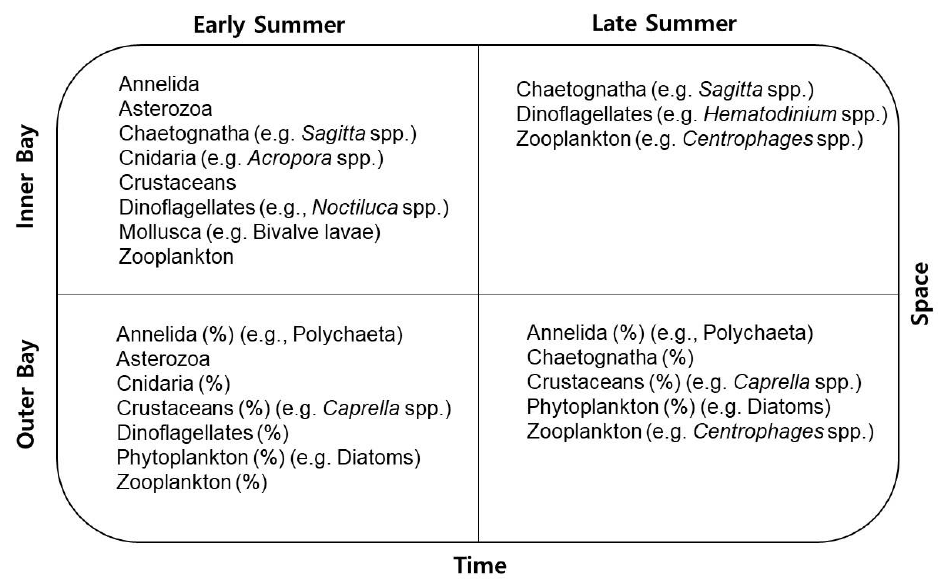
Figure 5. Main characteristics of marine plankton communities in Gwangyang Bay. The groups with % present relative abundance (derived from eDNA), and those without % present absolute abundance (derived from CMI).